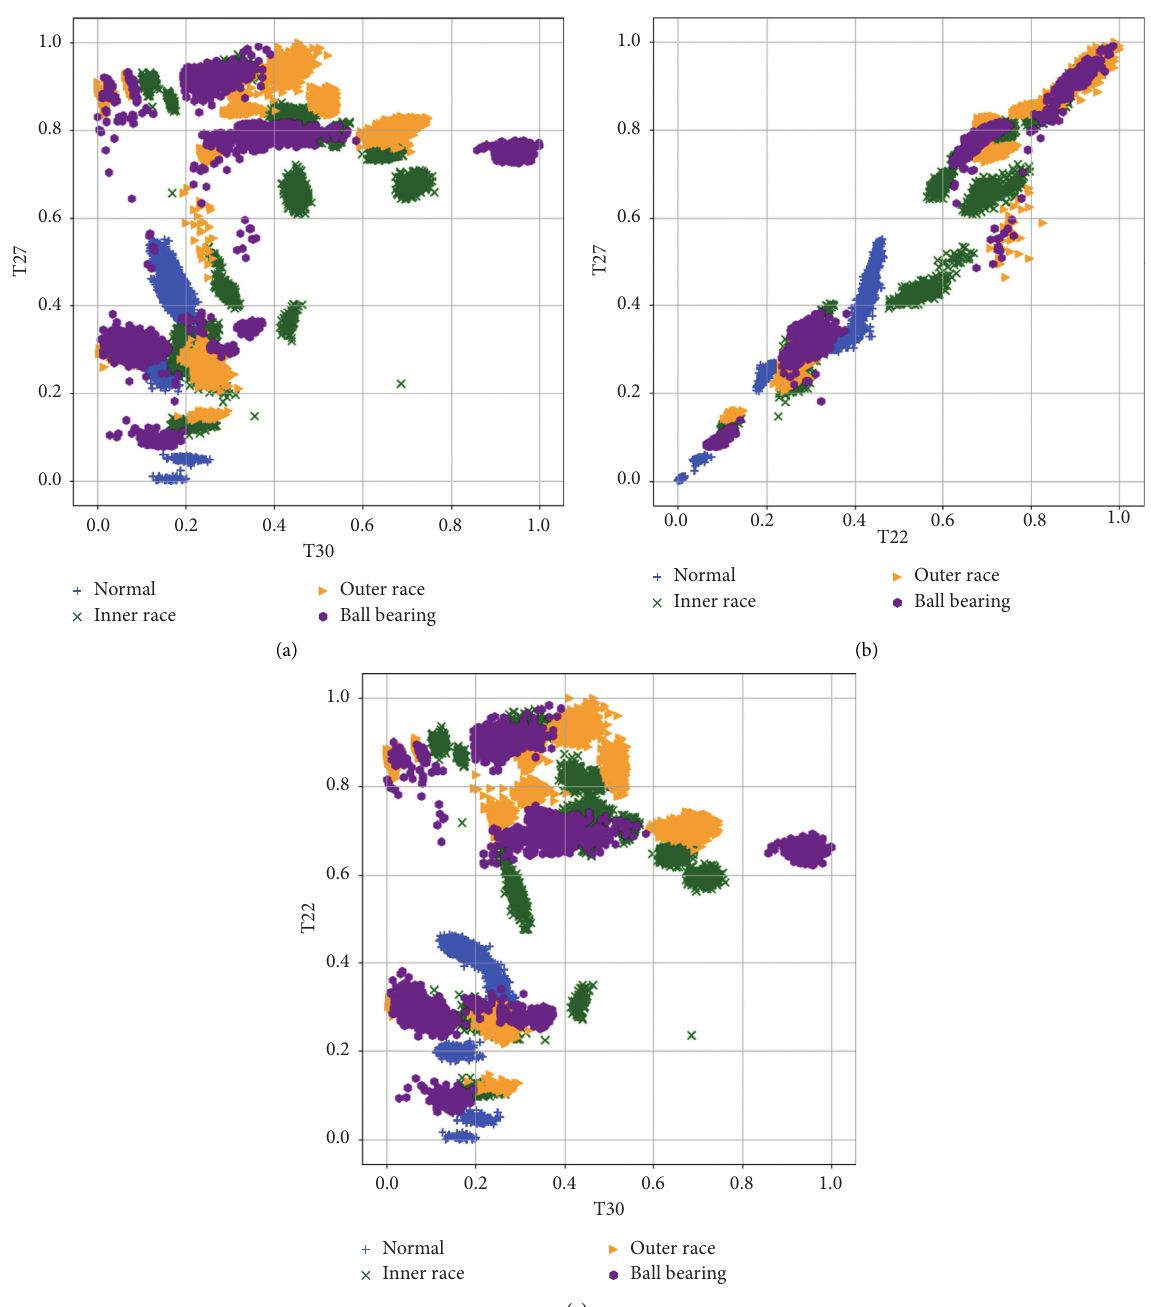
Figure 5: Pairwise scatter plots for the top 3 ranked features. (a) Between T27 and T30. (b) Between T22 and T27. (c) Between T22 and T30. Here T22, T27, and T30 are rate of zero crossing, Hjorth parameter—mobility, and normal negative log likelihood for single Gaussian,